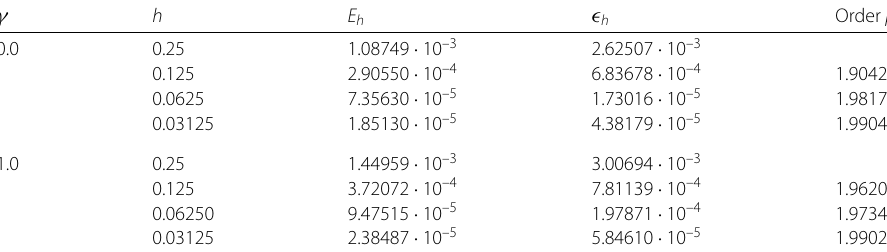
Table 2 The errors for different stepsizes h and γ γ h E h (cid:10) h Order p 0.0